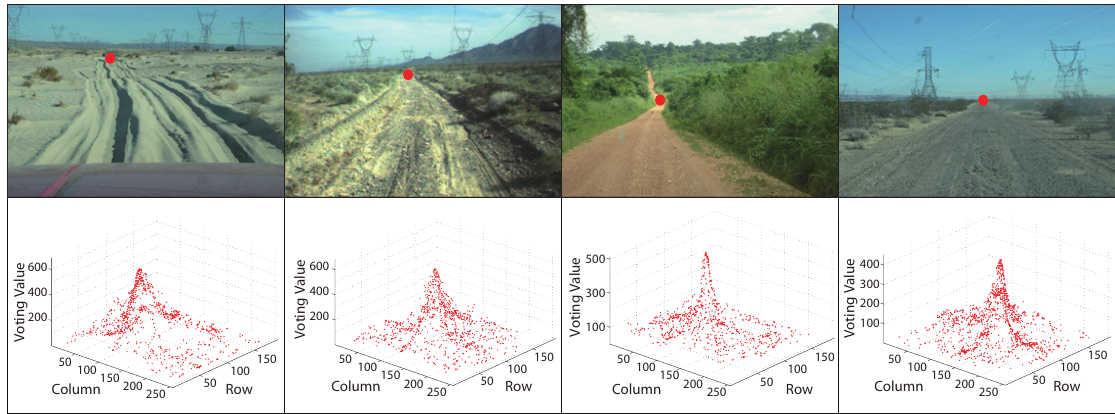
Figure 4. Examples of MPGA-based vanishing point detection in structured roads.